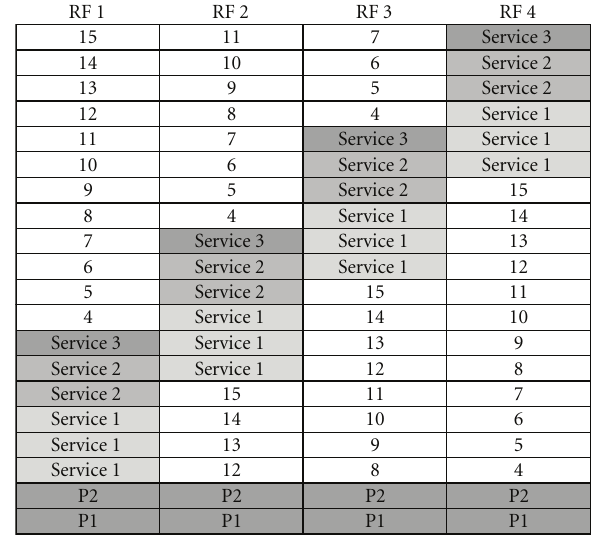
Figure 4: Example of a TFS frame for 4 RF channels and 15